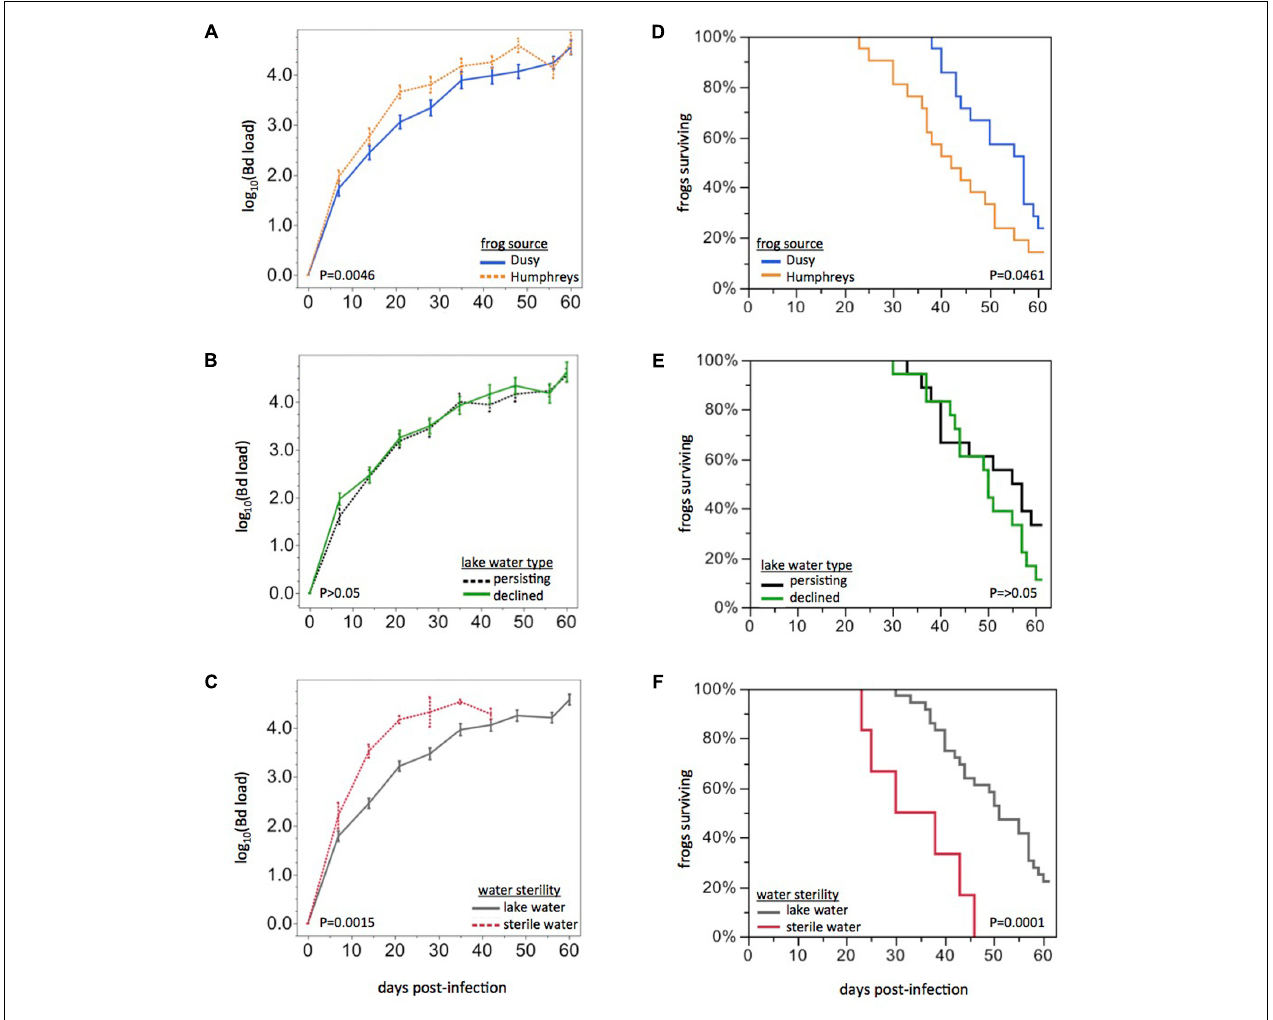
FIGURE 2 | Effects of frog source and water source on disease dynamics. Bd load trajectories and survival of frogs, grouped by Frog Source (top), Lake Water Type (middle), or Water Sterility (bottom). Rates of Bd load increase and survival curves were affected by Frog Source (A,D) and Water Sterility (C,F) but not Lake